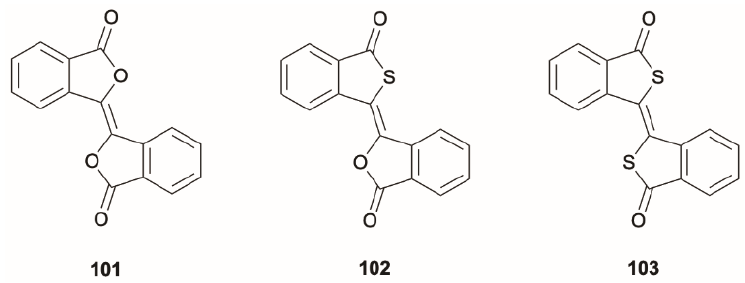
Figure 27. Suggested mechanism for the upper excited state fluorescence from neat solid 101 , 102 Figure 26. Possible mechanism for the dual TADF proposed for 100 on the basis of TDDFT calcula- and 103 , based on DFT/TDDFT calculations. Adapted with permission from [85]. tions (SOCME represents spin-orbit coupling matrix element). Adapted with permission from [84].